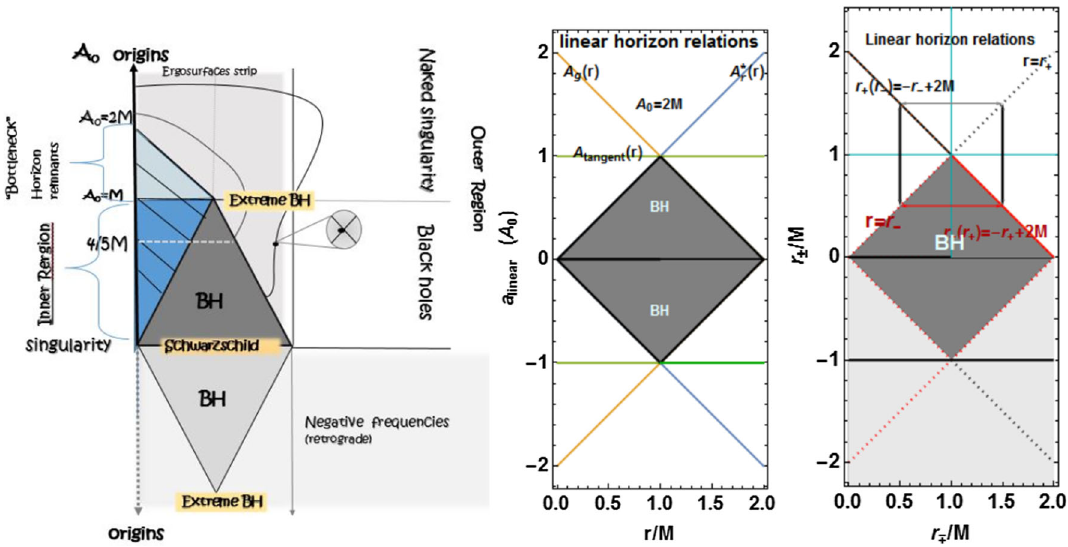
Fig. 2 Kerr extended plane. Horizons properties are independent of bundles. The interior region , exterior region and the bottleneck region √ σ . The plane is split in the negative are defined, for example, in Fig. 21. The transformations are given in the plane σ ≡ sin 2 θ . Here A ≡ a Eq. (74). The linear relations for the horizons in the extended plane are frequencies region ( a < 0 ) (below part) and the upper part for posi- obtained explicitly in [1], for example, in the ( r − r ) plane. The cen- tive bundle characteristic frequencies. Central gray triangle is the BH ter panel represents the extended plane ( a , r ) with the transformations in the positive a 0 > 0 region of the extended plane. This contains all given in Eq. (74) and Fig. 21). The right panel shows the linear relations the Kerr BH geometries. Each point of a bundle is represented on the within the transformations r ∓ ( r ± ) of [1] plane. In the left panel, each point of a bundle is a crossing point of two